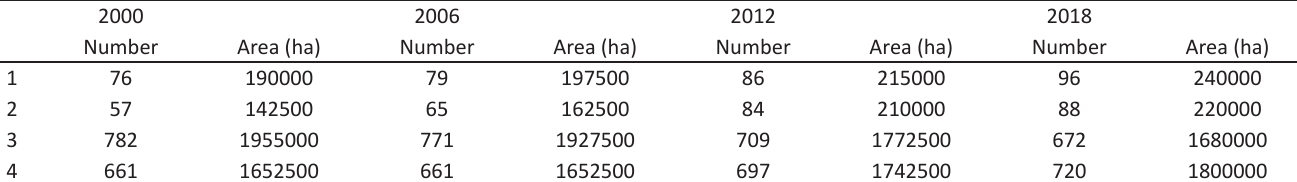
Figure 6. Changes in land cover based on CLC data and the proposed classification relative to the satellite images acquired in Table 2. Number and area of land cover classes in 2000, 2006, 2012 and 2018.